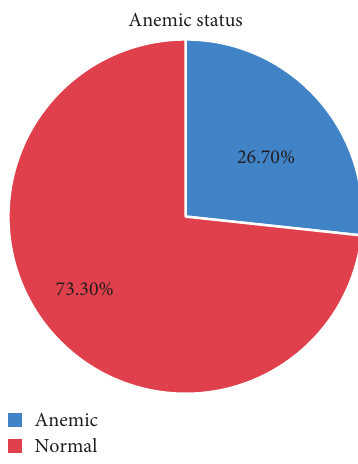
Figure 1: The prevalence of anemia among secondary school adolescent girls in Jimma Town, southwest Ethiopia.